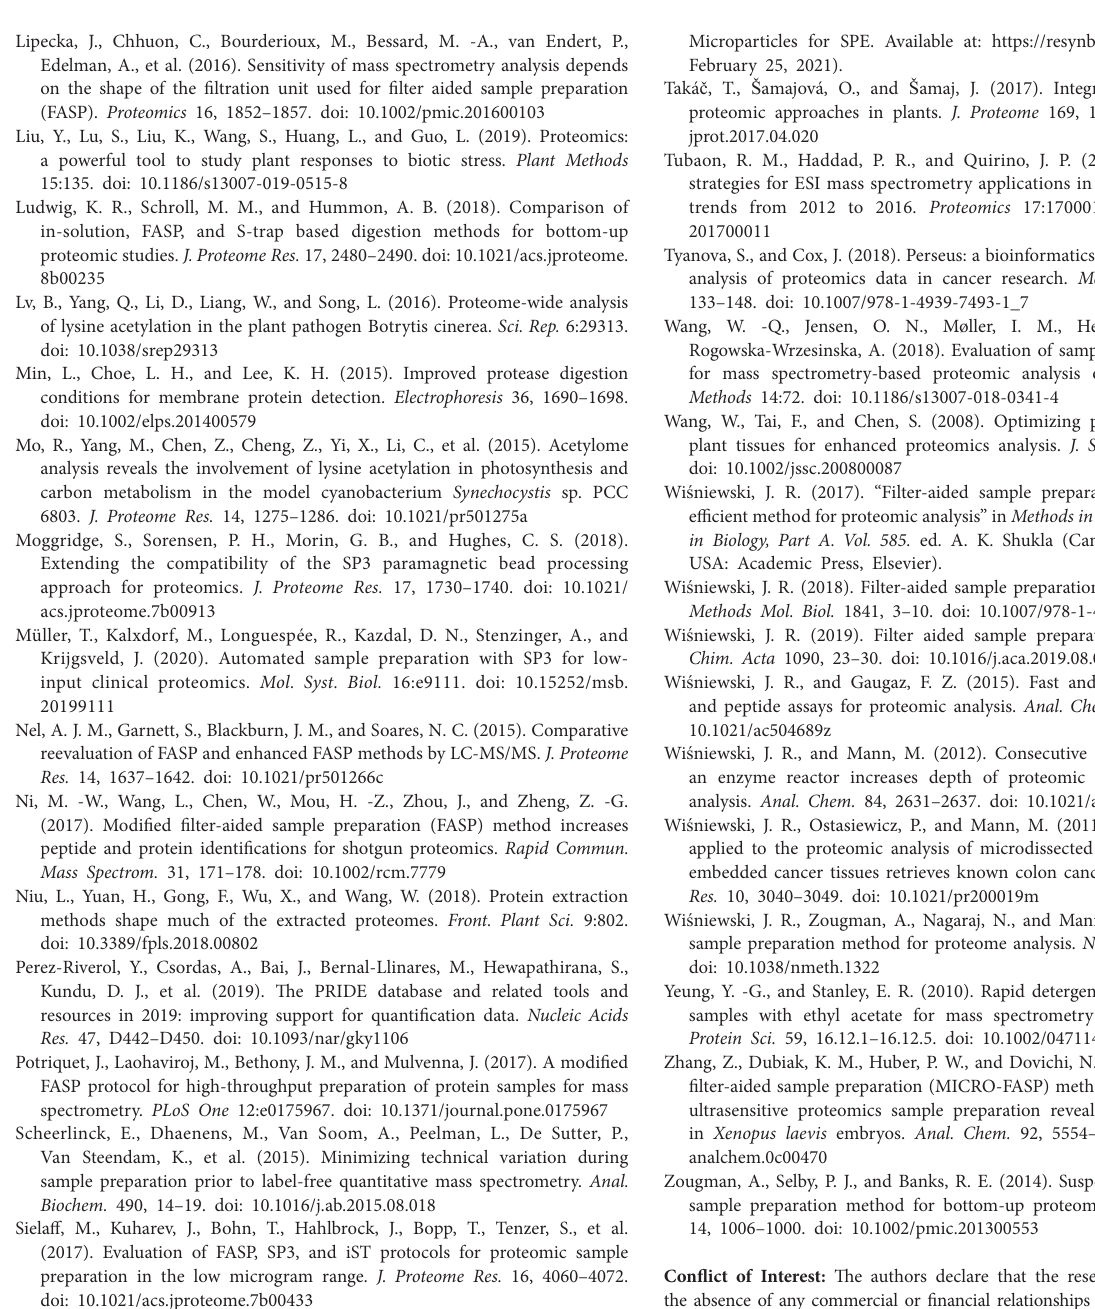
SP3 Protocol for Proteomic Plant